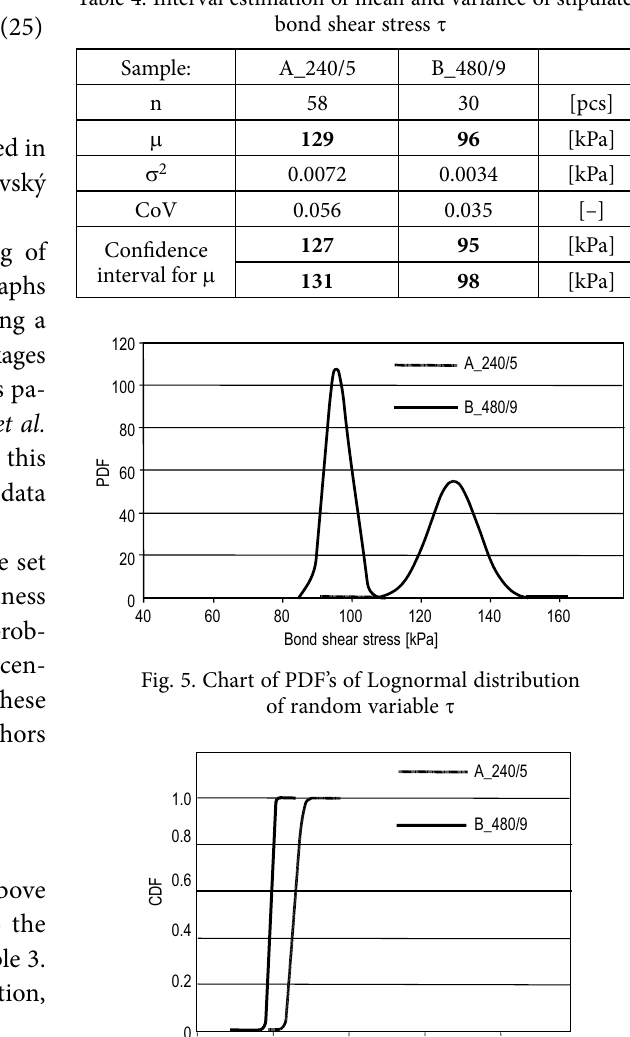
Table 3. Moments and parameters of Lognormal distributions assigned to the random variable Δ